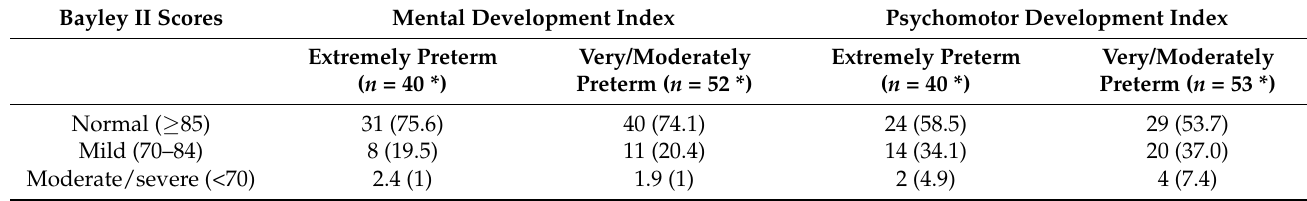
Table 3. Distribution of MDI and PDI scores in groups. Values are number of infants (percentage). * MDI and PDI data were missing for one infant in EP group, MDI data were missing for two infants and PDI data for one infant in VP